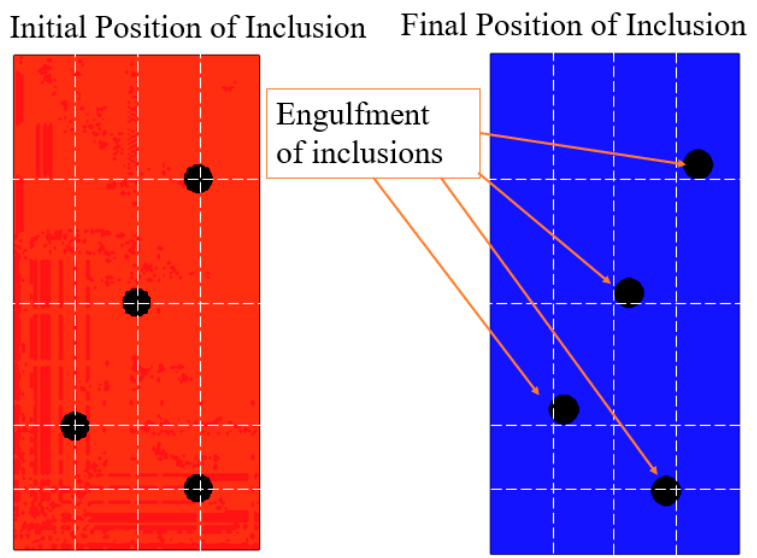
Figure 12. Engulfment of inclusion particles during solidification (S: 10 ppm).